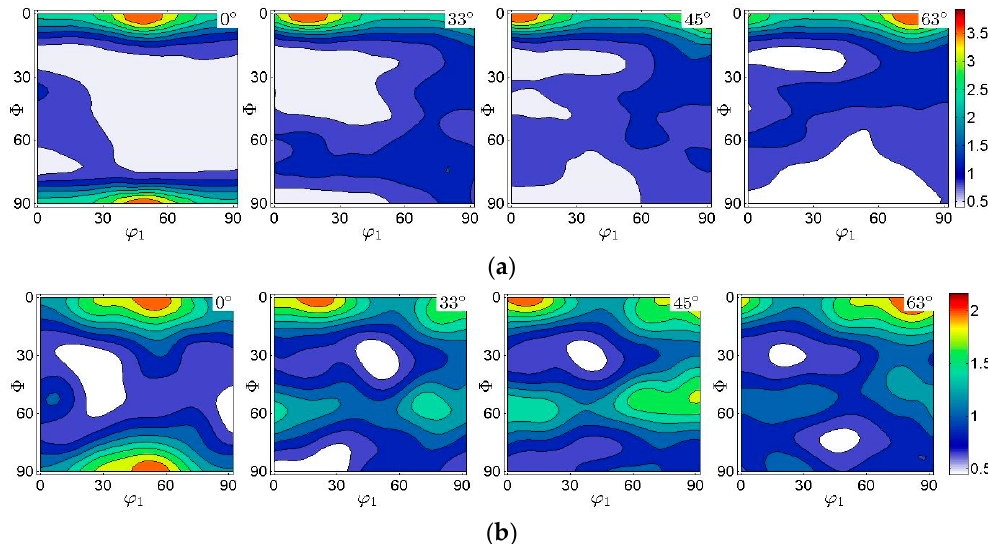
Figure 10. The important cross-section of the initial orientation distribution function (ODF). ( a ) Calculated by the pole figures. ( b ) Calculated by the Euler angles.